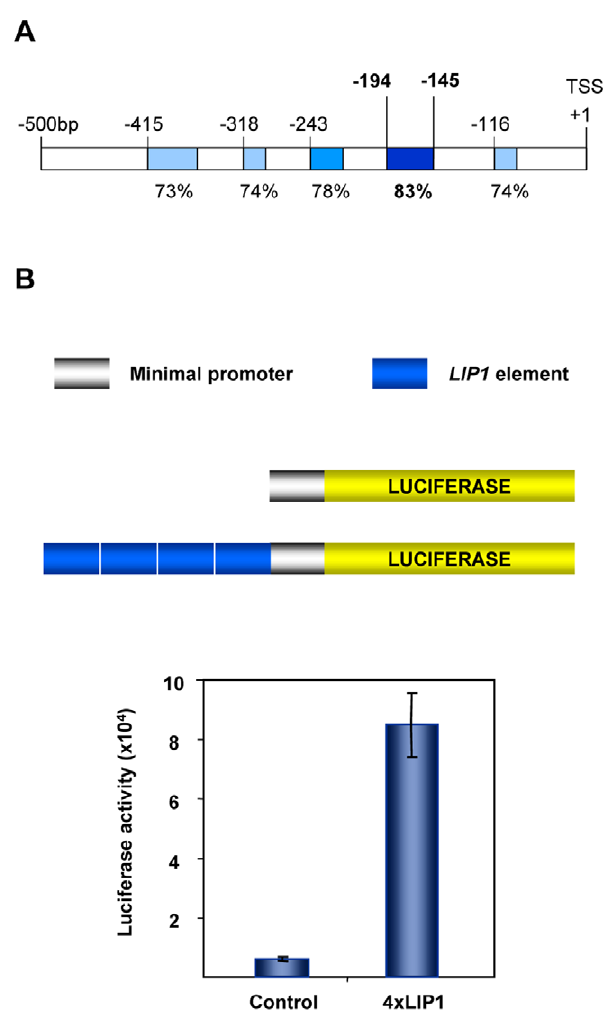
Figure 1. Identification of functionally relevant promoter cis - elements in a GDSL-lipase gene from A. thaliana . ( A ) The promoter of the A. thaliana GDSL-lipase gene (At5g45670) and their orthologous promoters in other Brassicaceae species were subjected to in silico analysis to identify conserved sequences (shaded boxes). Although over 1 Kb of each promoter was analyzed, significantly conserved sequences were found only along the first 500 bp upstream of the translation start site (TSS). The sequence with the highest degree of conservation (83% identity) is represented as a dark blue box and spans 50 bp ( LIP1 element). ( B ) A binary plasmid (pYRO) containing a minimal promoter fused to the luciferase reporter gene (control) was used to clone four copies of the 50 bp sequence ( 4xLIP1 ) and both constructs were used to produce A. thaliana transgenic plants. Luciferase activity was quantified in vivo from transgenic seeds 24 h after imbibition. Average values and standard errors from 10 independent lines for each construct (20 seeds/line) are